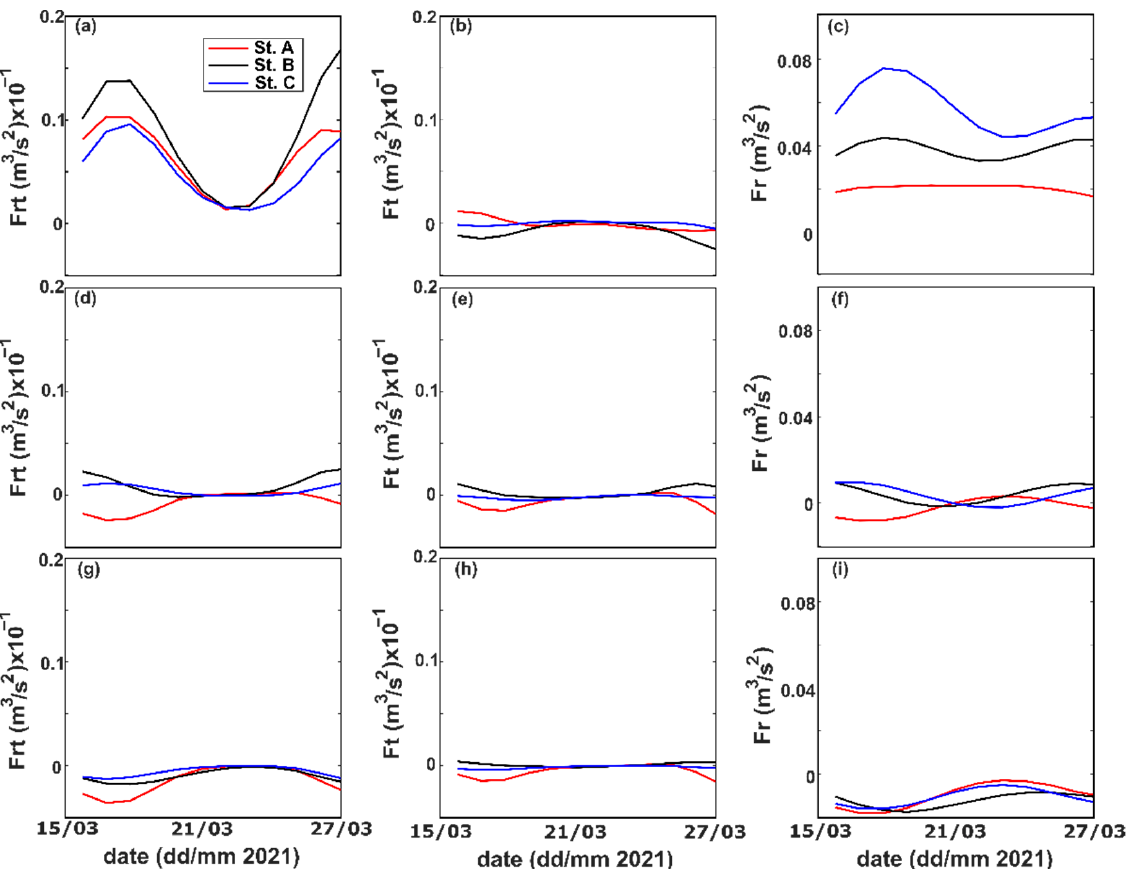
Figure 8. Frt ( a , d , g ), Ft ( b , e , h ), and Fr ( c , f , i ) at upper ( top row), mid ( middle row), and lower depth ( bottom row) in Stations A, B, and C.